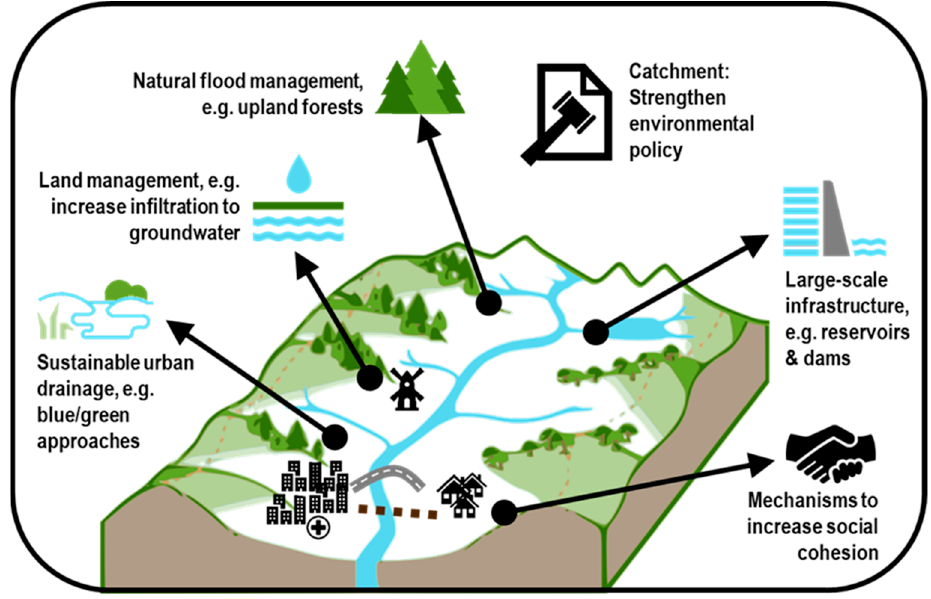
Figure 3. Examples of possible resilience-enhancing measures in a river catchment.